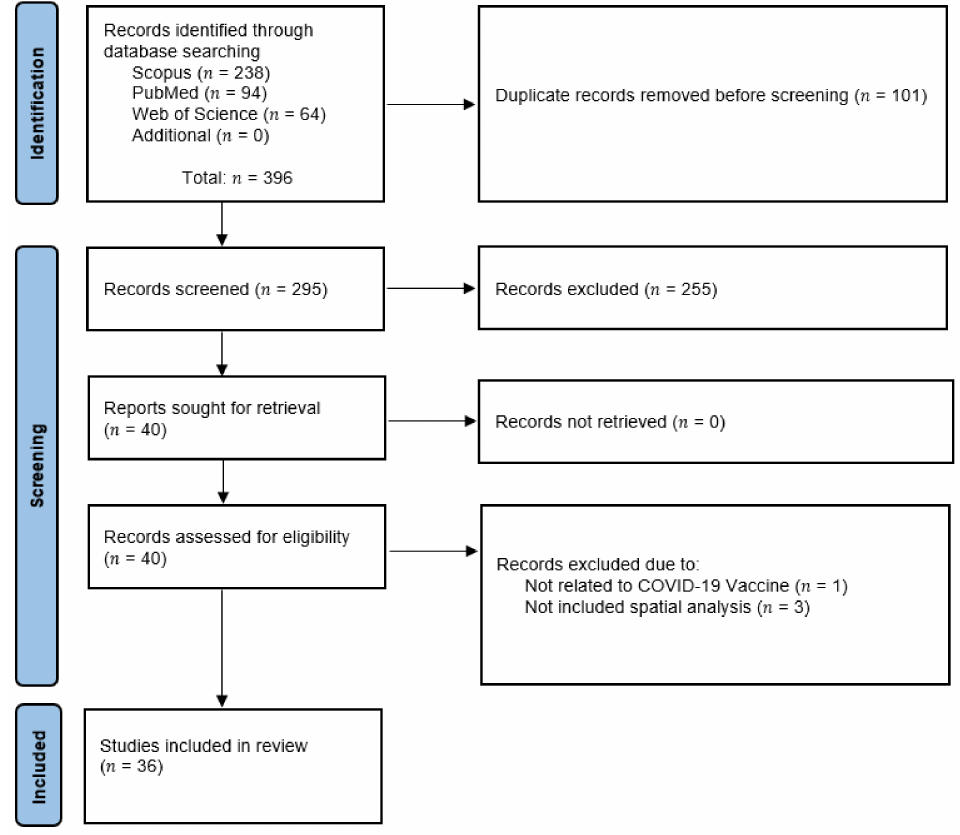
Figure 1. Study selection flow